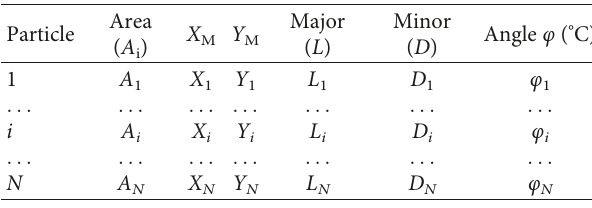
φ i Figure 6: Scanned images of the six faces of the RVE of size 60 × 60 × 60mm 3